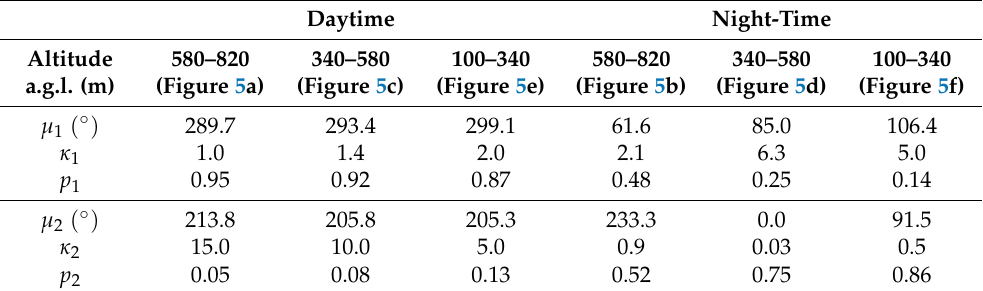
Figure 5. Wind roses showing the prevailing wind speeds and directions in Granada at three different height ranges, distinguishing between daytime ( a , c , e ) and night-time ( b , d , f ). Black lines stand for the fitted von Mises distributions, parameterized by values in Table 3. Table 3. Parameters corresponding to bimodal von Mises distributions fitted to daytime and night- time wind directions divided into three height ranges.